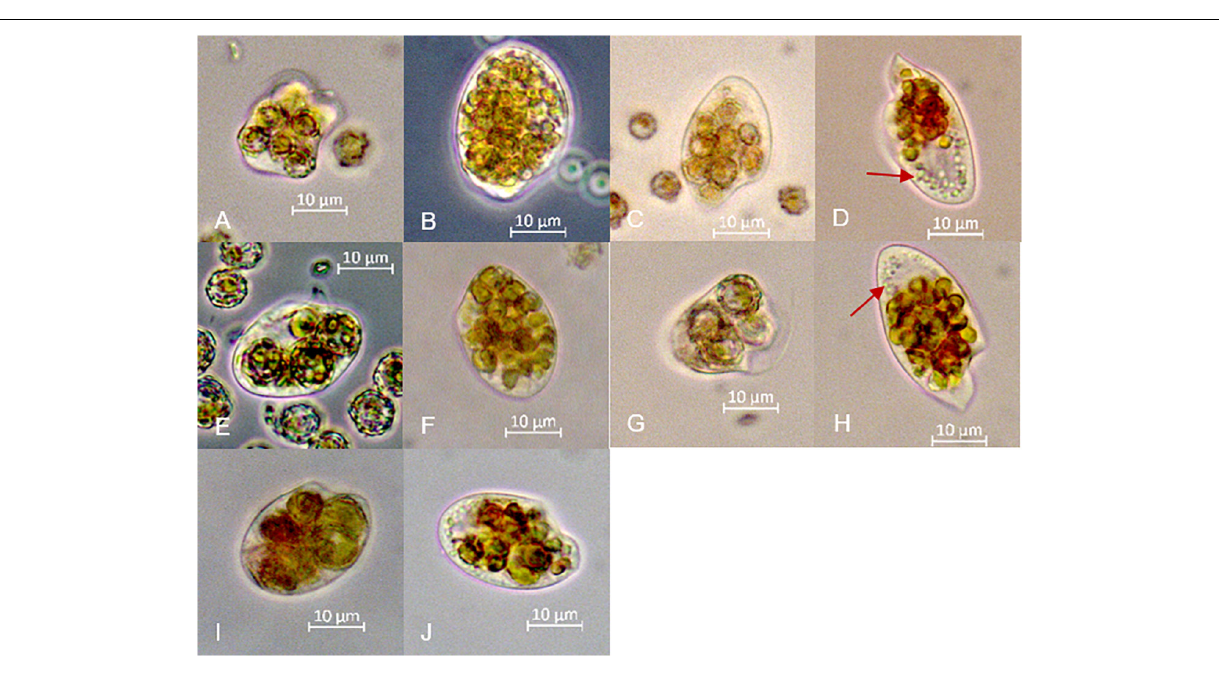
FIGURE 5 | Microscopic images of different individuals of O. marina with ingested prey. (A) calcified and (B) decalcified E. huxleyi after 24 h. (C) calcified and (D) decalcified E. huxleyi after 72 h. (E) calcified and (F) decalcified G. oceanica after 24 h and (G) calcified (H) decalcified cells after 72 h. (I) calcified and (J) decalcified P. carterae after 24 h. Red arrows point to the small spherical objects in the apical part of the predatory cells, which resemble prey cells in an advanced stage of